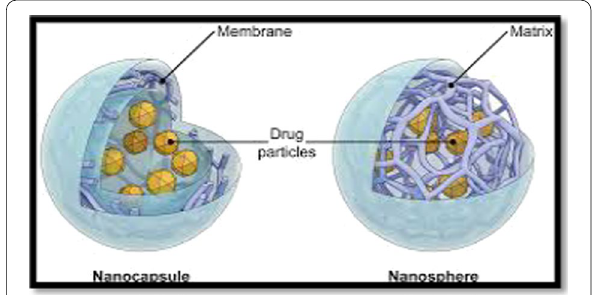
Fig. 2 Schematic representation of nanospheres and nanocapsules [11]